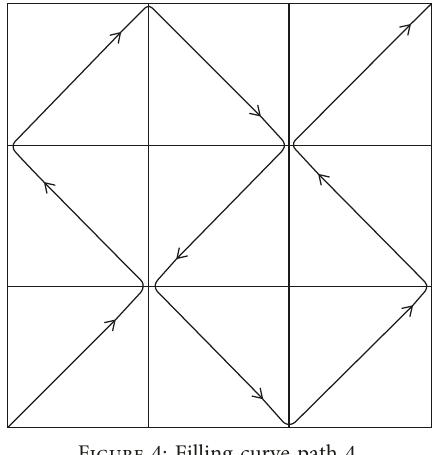
Figure 4: Filling curve path